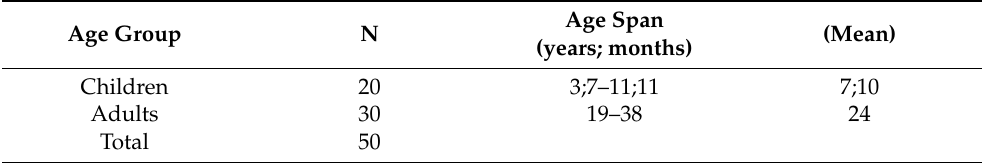
Table 3. Monolingual control